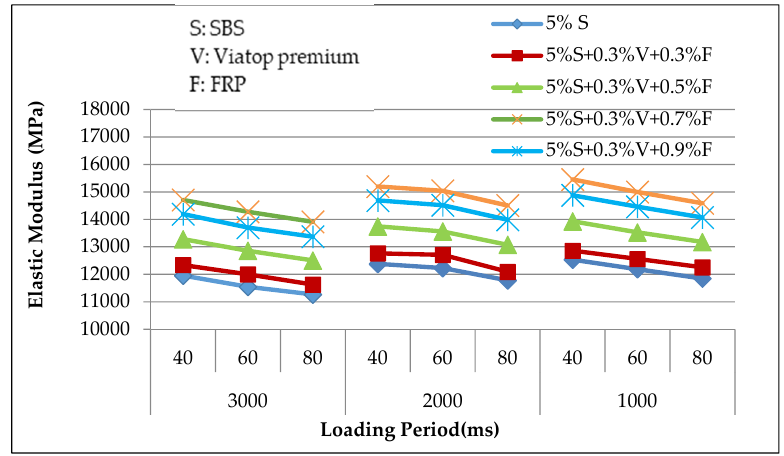
Figure 7. Resilient modulus test results, 5 °C.